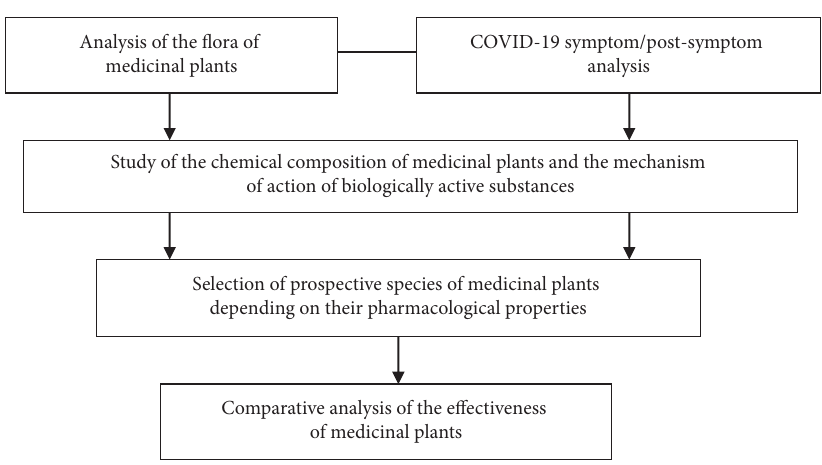
Figure 1: Research